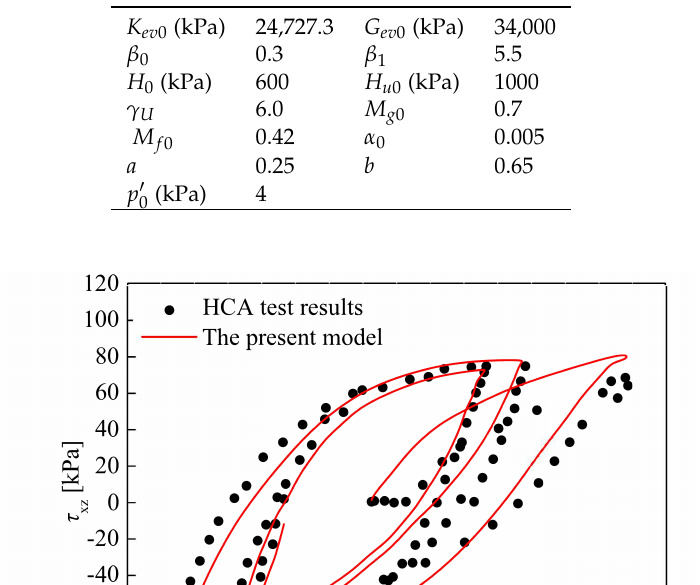
Table 1. Present constitutive model’s parameters for comparison with the HCA (Hollow Cylinder Apparatus) element test of sand [56].